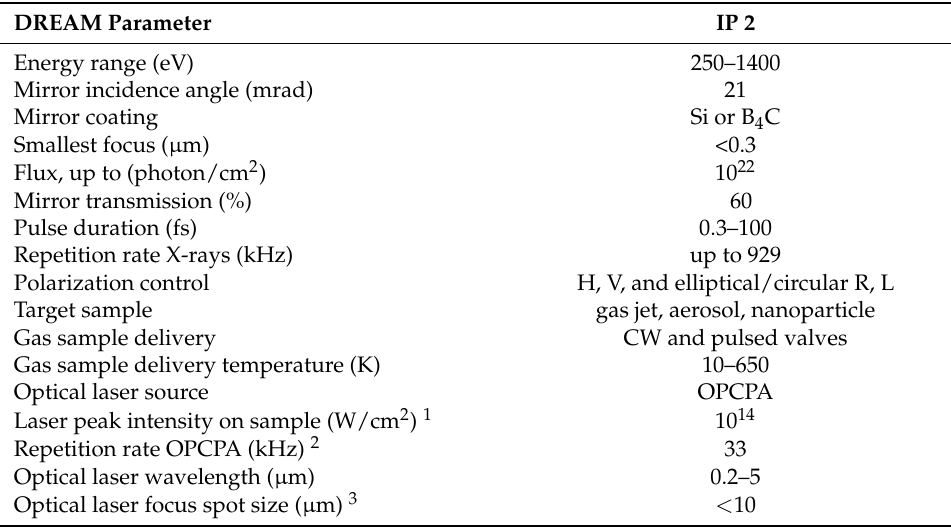
Table 3. Parameters and capabilities of the DREAM